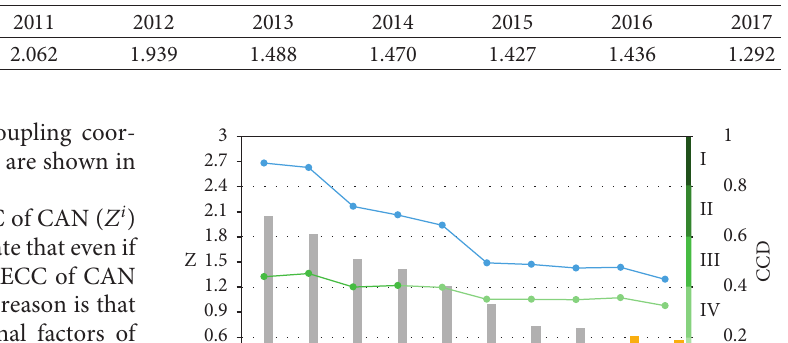
Table 4: The comprehensive evaluation result of